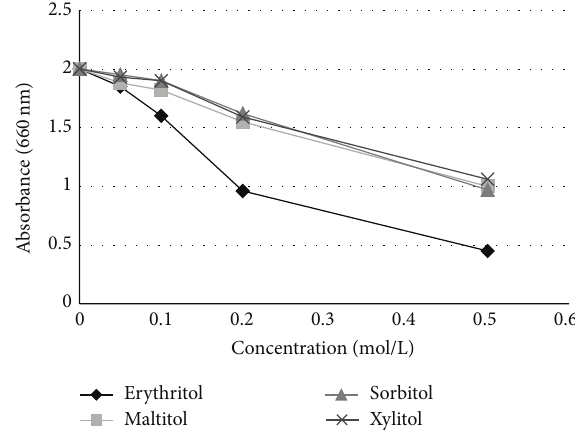
Figure 3: Effect of polyol concentration (mol/L) on growth of S. mutans (strain 267-S) after 5 hours. Adapted from M¨akinen et al. [10] and M¨akinen [36].